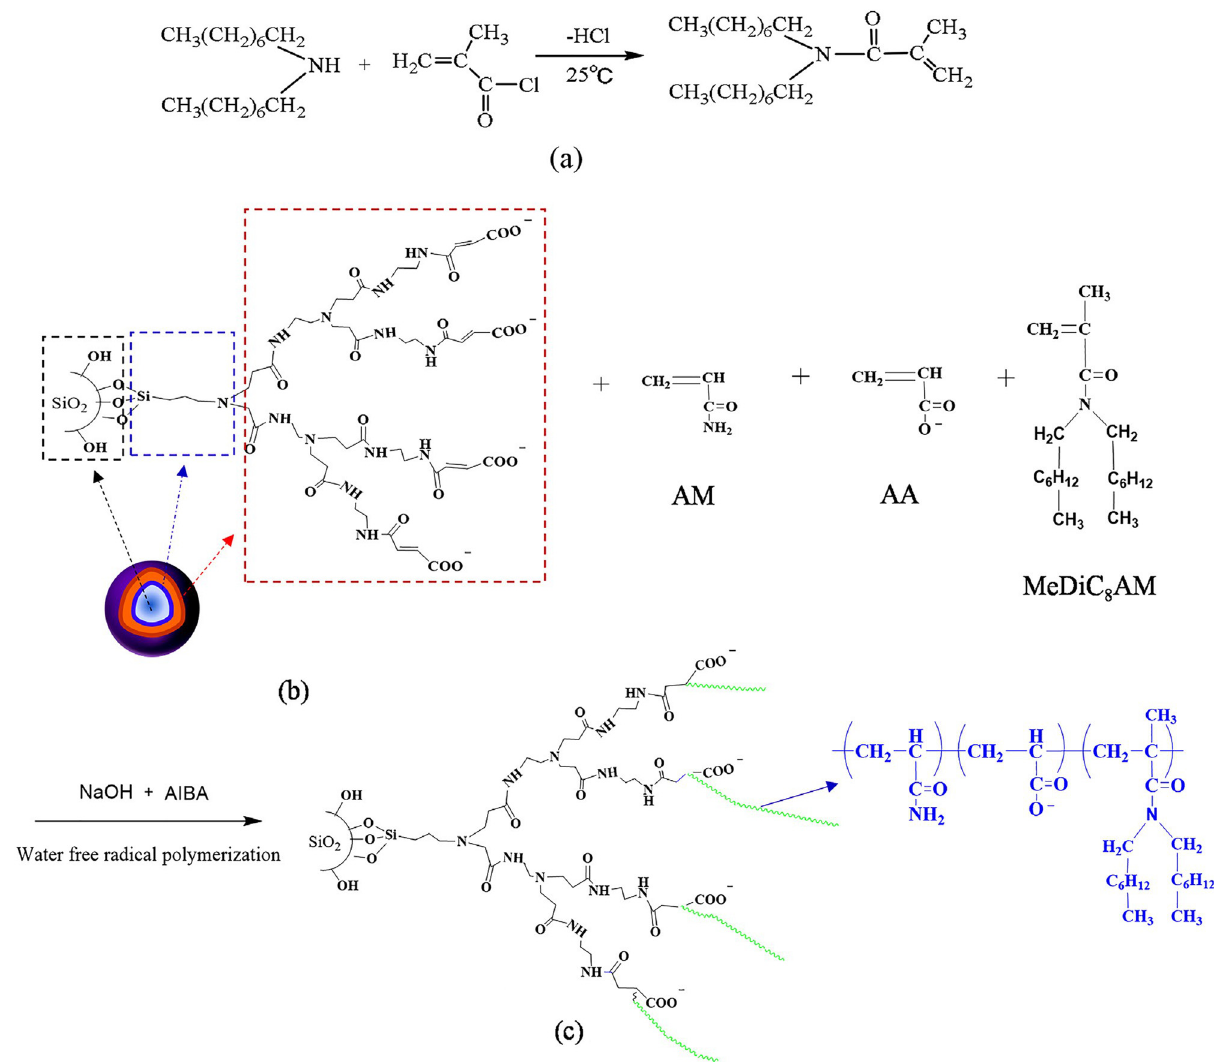
Figure 3: Synthesis method of SHPAM [ 98 ] . ( a ) MeDiC 8 AM, ( b ) FNPs ( diameter of 30 nm ) , and ( c )